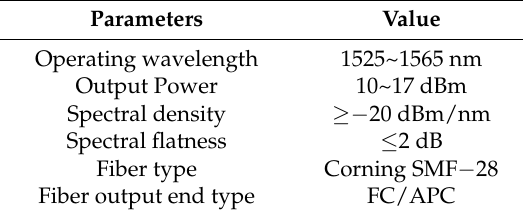
Table 2. Parameters of ASE light source.